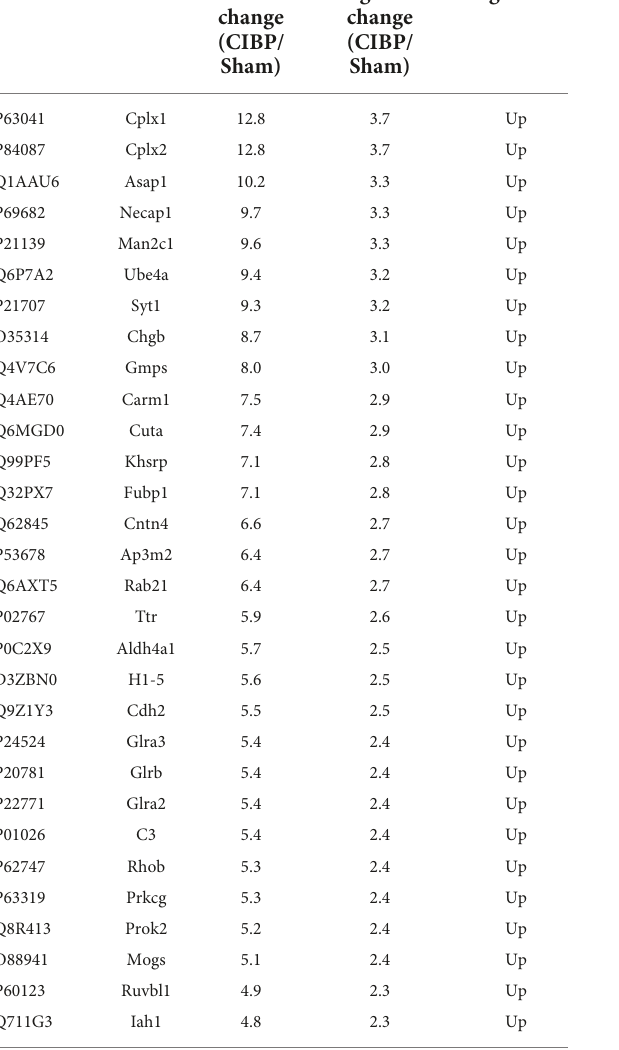
Log2 fold change (CIBP/